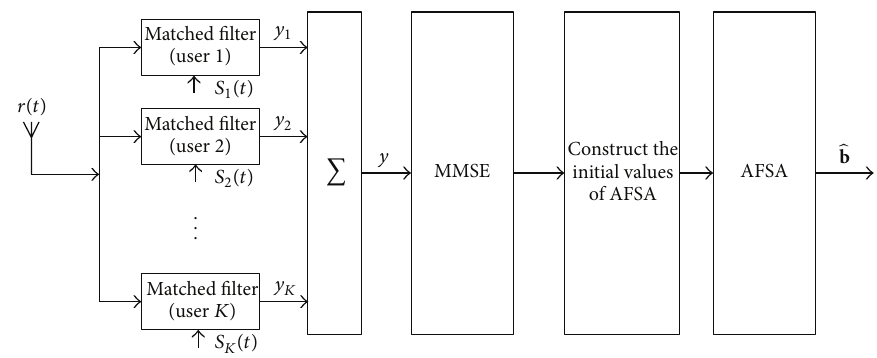
Figure 2: Diagram of MMSE-AFSA